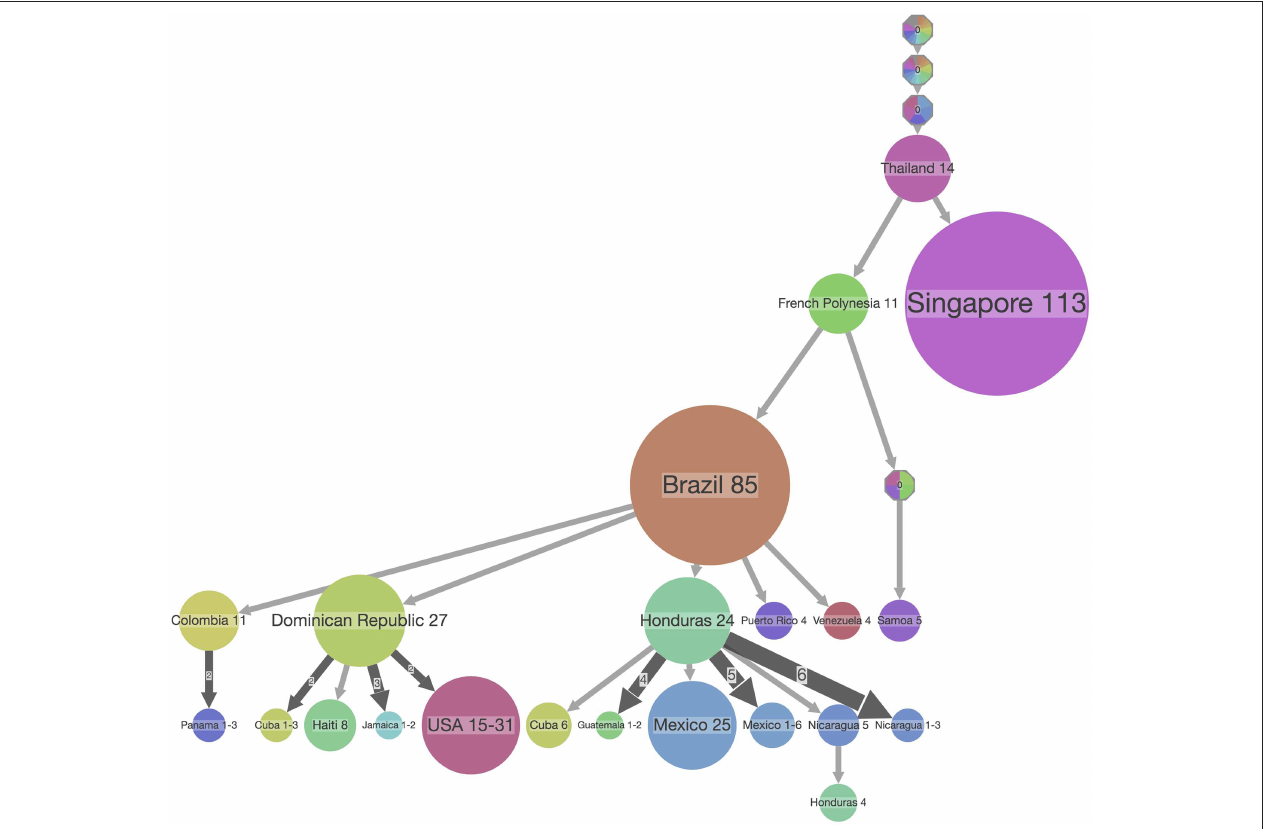
FIGURE 7 | PASTML summary visualization of the ancestral reconstruction of state locations of the ZIKV dataset used in Figure 6 . The top-down visualization corresponds to an iterative clustering starting from the root of the tree at the top, with the size of the dot corresponding to the number of taxa in a clade which share the same ancestral state which is indicated on top of the dot. In this type of visualization, a compressed representation of the ancestral scenarios is visualized that highlights the main facts and hides minor details by performing both a vertical and horizontal merge [but see (33)]. The branch width corresponds to the number of times its subtree is found in the initial tree, and the circle size at a tip is proportional to the size of the compressed (or merged)